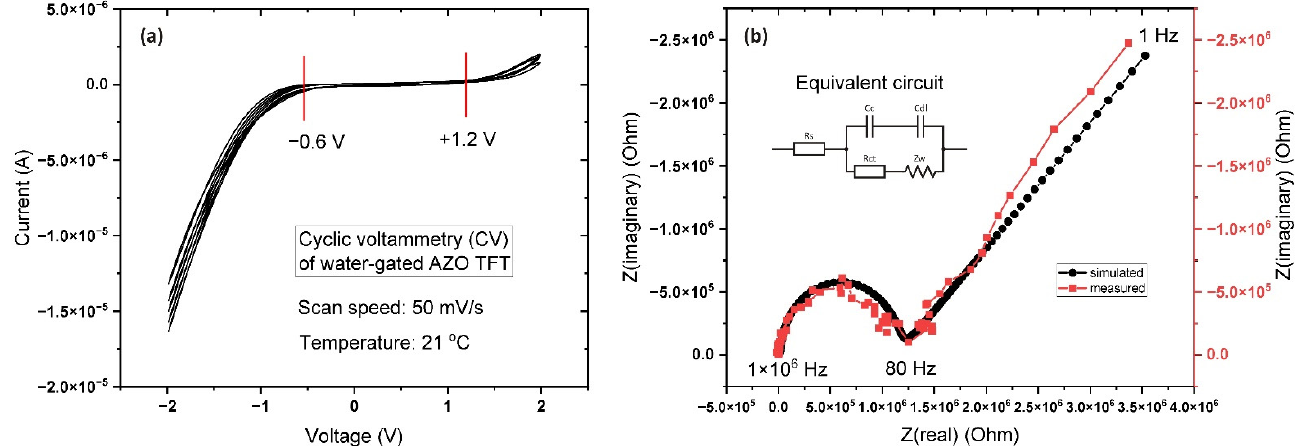
Figure 4. ( a ) Cyclic I − V curve for DI water in contact with a metal/semiconductor (red vertical lines indicate the electrochemical window for the particular device (chromium/DI water/Al:ZnO) that is equal to 1.8 V); ( b ) Nyquist plot of the impedance spectra for Al:ZnO EGFET and the equivalent electrical circuit. An AC signal is applied between the gate electrode and the shorted together drain-source electrodes.